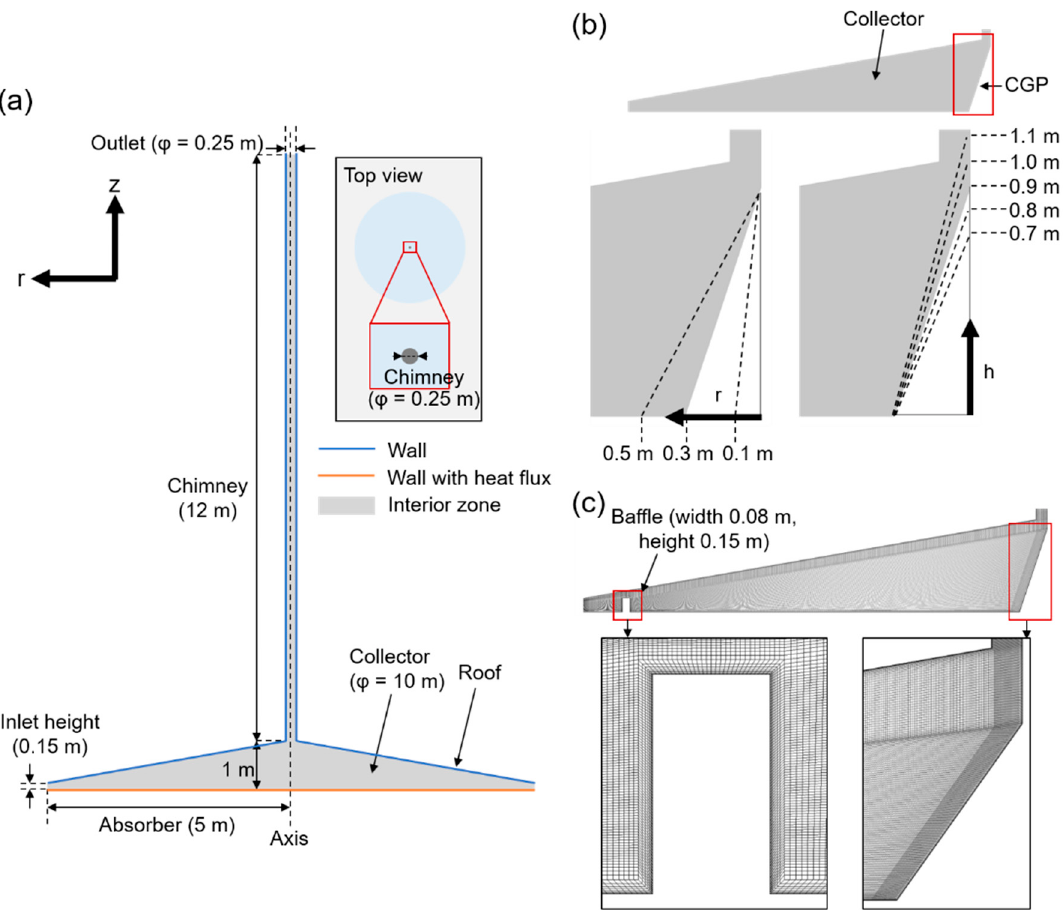
Figure 2. Two-dimensional (2D) axisymmetric geometry of the computational domain used in this study. ( a ) Schematic diagram of the principle 2D axisymmetric geometry of SUT without CGP and baffle. ( b ) Detailed geometry of the CGP models with different radius and height. ( c ) Two quadrilateral grid systems applied for meshing the whole computational domain in the CGP model.